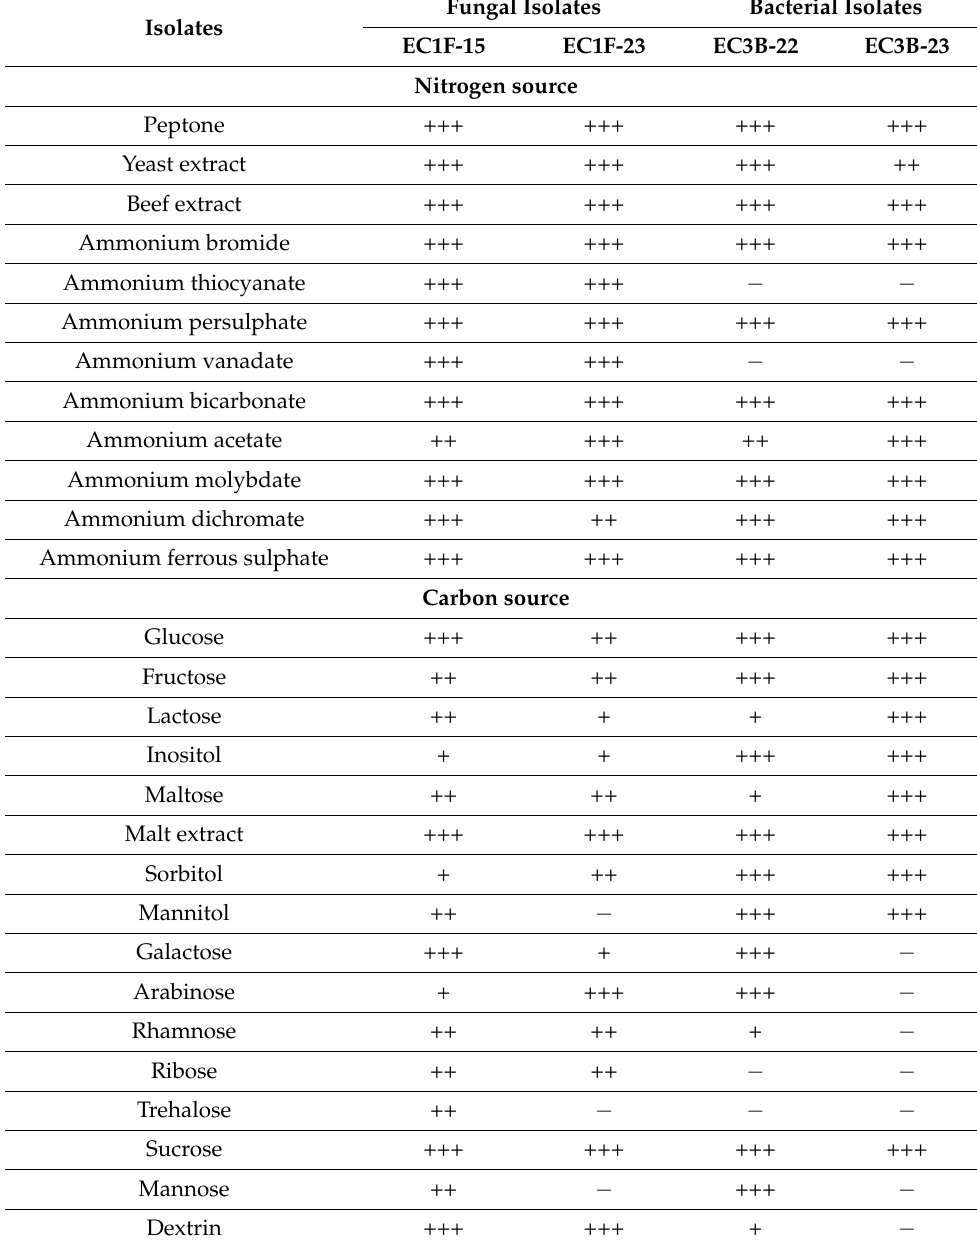
Table 5. Growth of endophytes on different nitrogen and carbon